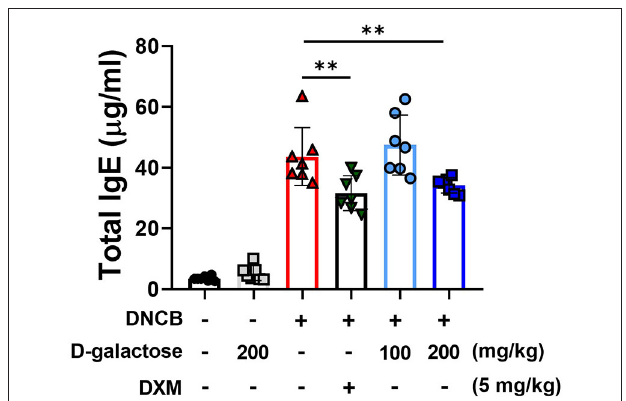
FIGURE 3 | Effects of D-galactose on DNCB-induced serum IgE levels in mice. Blood was collected on the day of sacrifice in the experiment (day 14). The level of serum IgE was measured with ELISA. Values are means ± SD. Significant differences between the groups were assessed using Mann-Whitney U -test, with the level of significance set at * P < 0.05, ** P < 0.01, *** P <